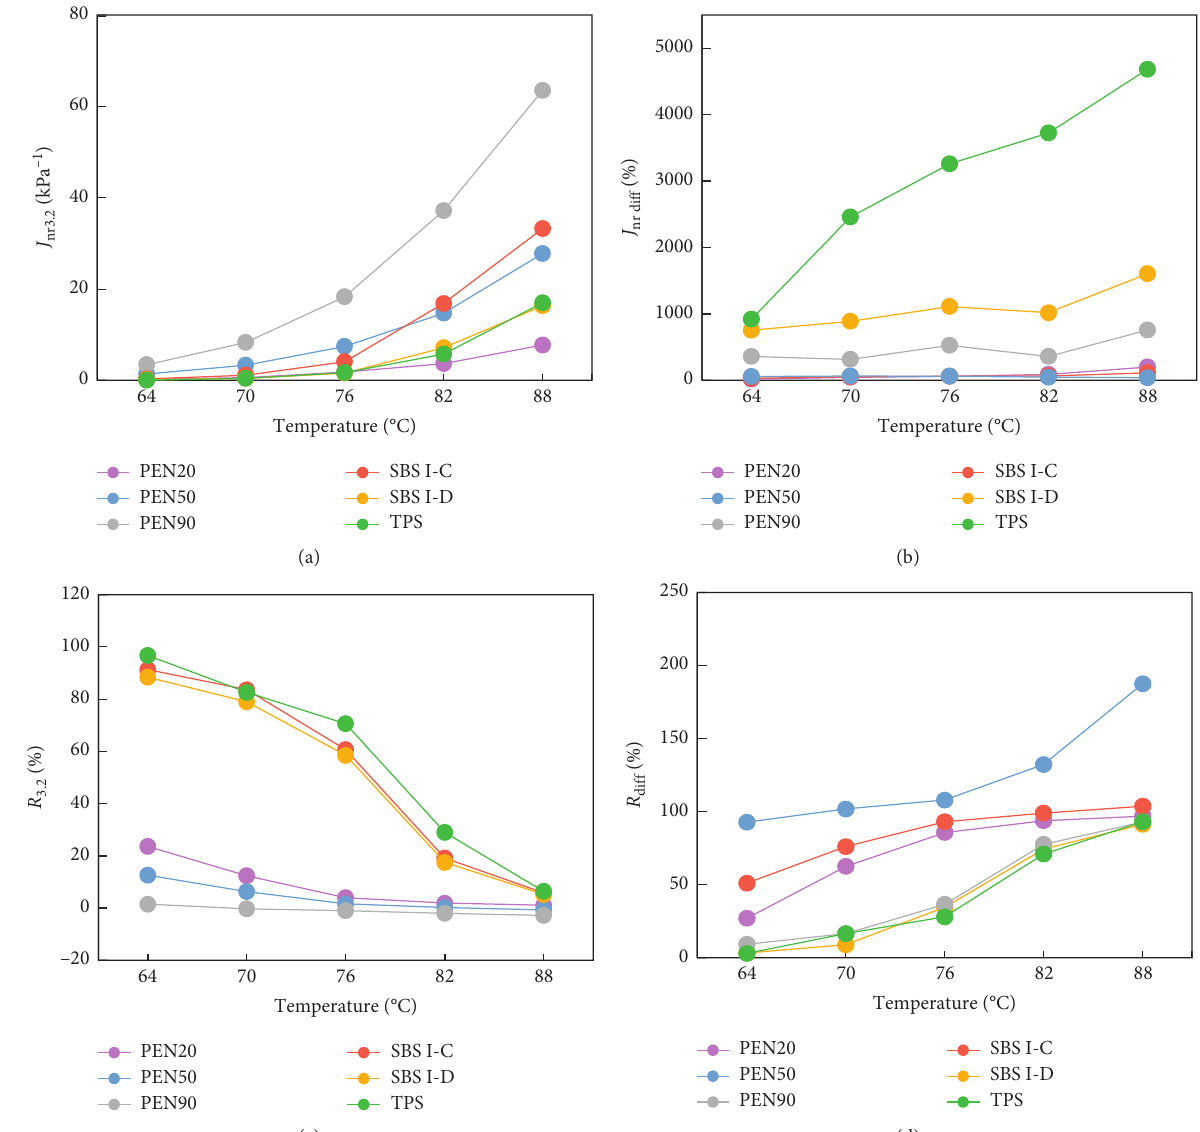
Figure 2: Multiple stress creep recovery (MSCR) test results of six asphalt